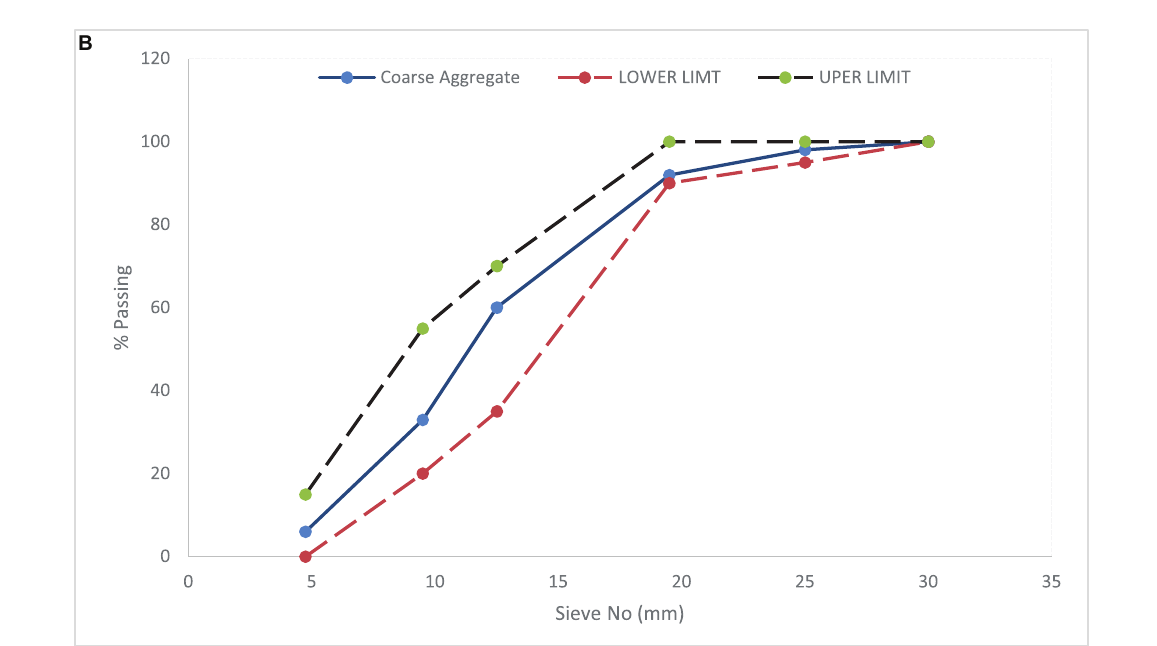
Frontiers in Materials |